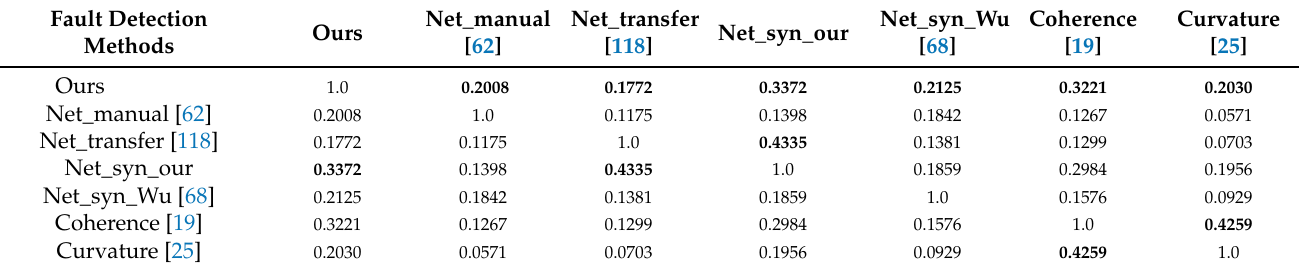
Table 2. Results Comparison Test with F1 Score in Work Area B.